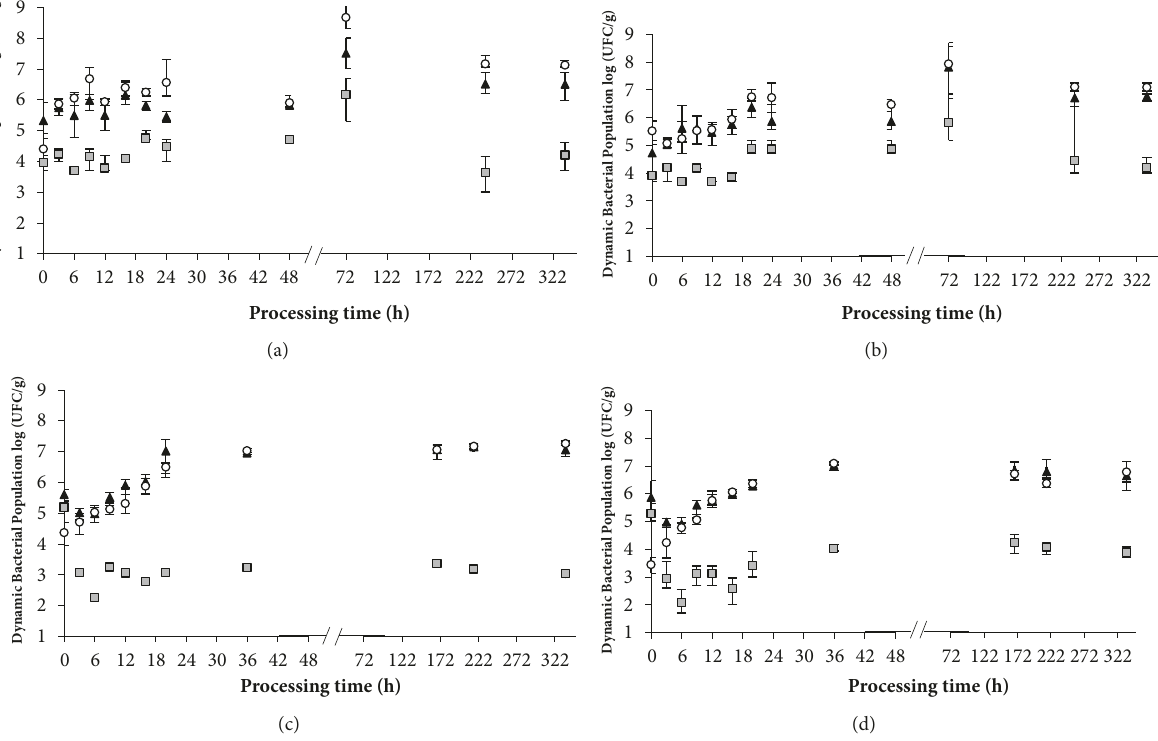
Figure 2: Dynamics of the microbial population during the processing of salami: fermentation at 21 ∘ C from 0 to 48 h and ripening at 17 ∘ C to 336 h (14 days). CNS (grey square), total bacterial count (black triangle), and LAB (white circle). Treatments Ls-Sc (a), Ls-Sc + (b), C (c), and C + (d). The bars indicate the confidence intervals.